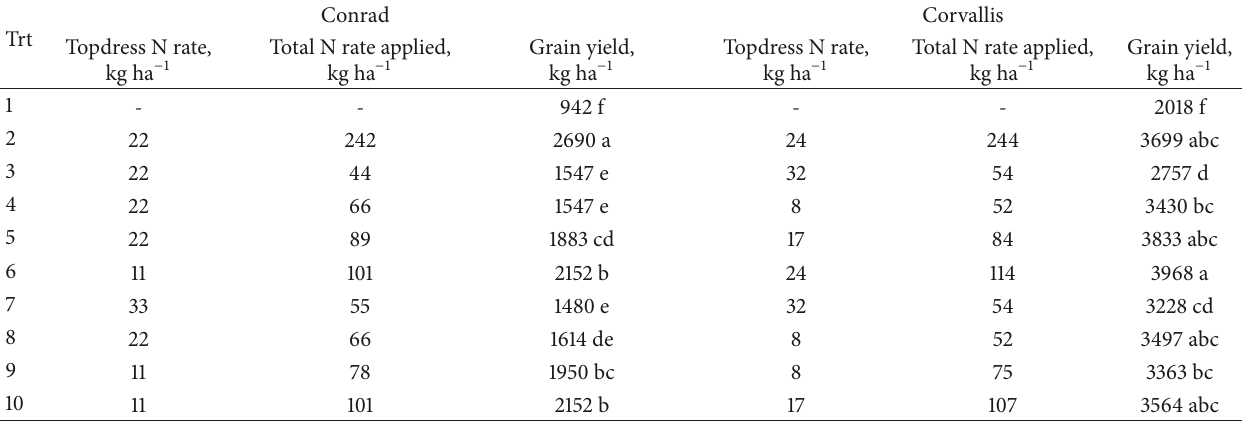
Table 3: Preplant N rate, topdress N rate, topdress N source, total N rate applied, and spring wheat grain yield, Conrad and Corvallis, MT, 2011.